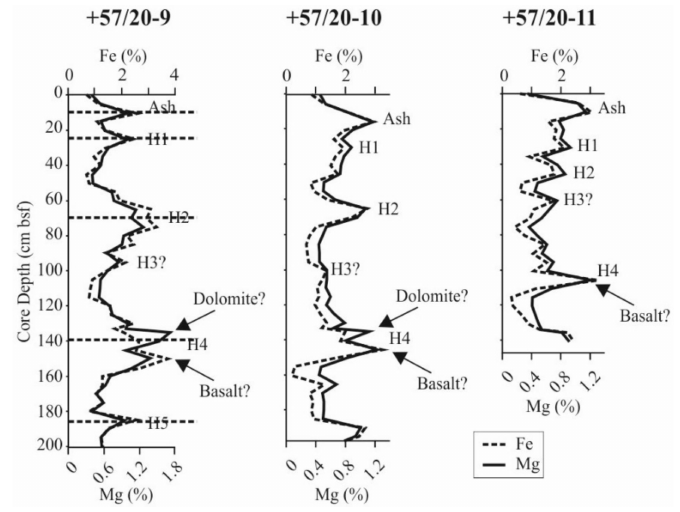
Figure 6. Depth profile of Fe and Mg content in three sediment cores from the study area where decoupling peaks of these elements in H4 are assigned to their possible origin, i.e., basalt (Fe) or dolomite